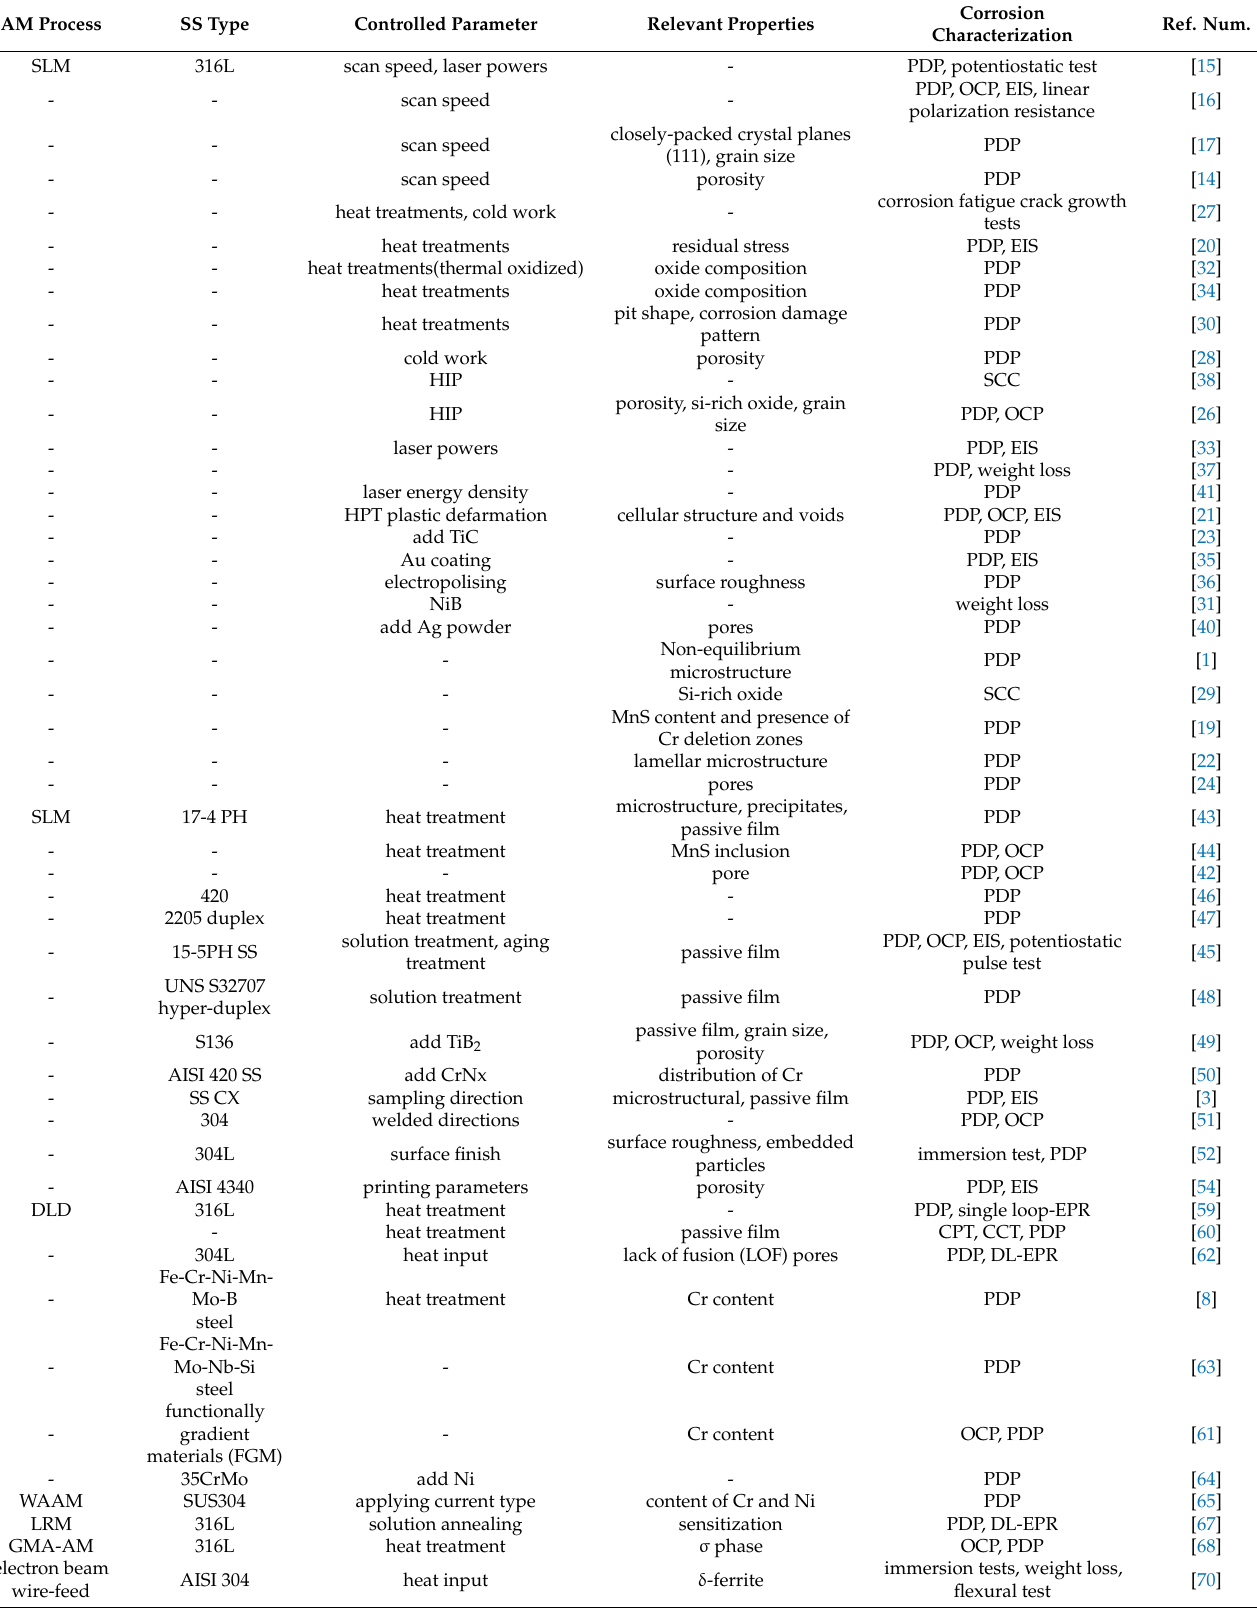
Table 1. Summary of relevant literature that specifies the controlled parameters and the relevant